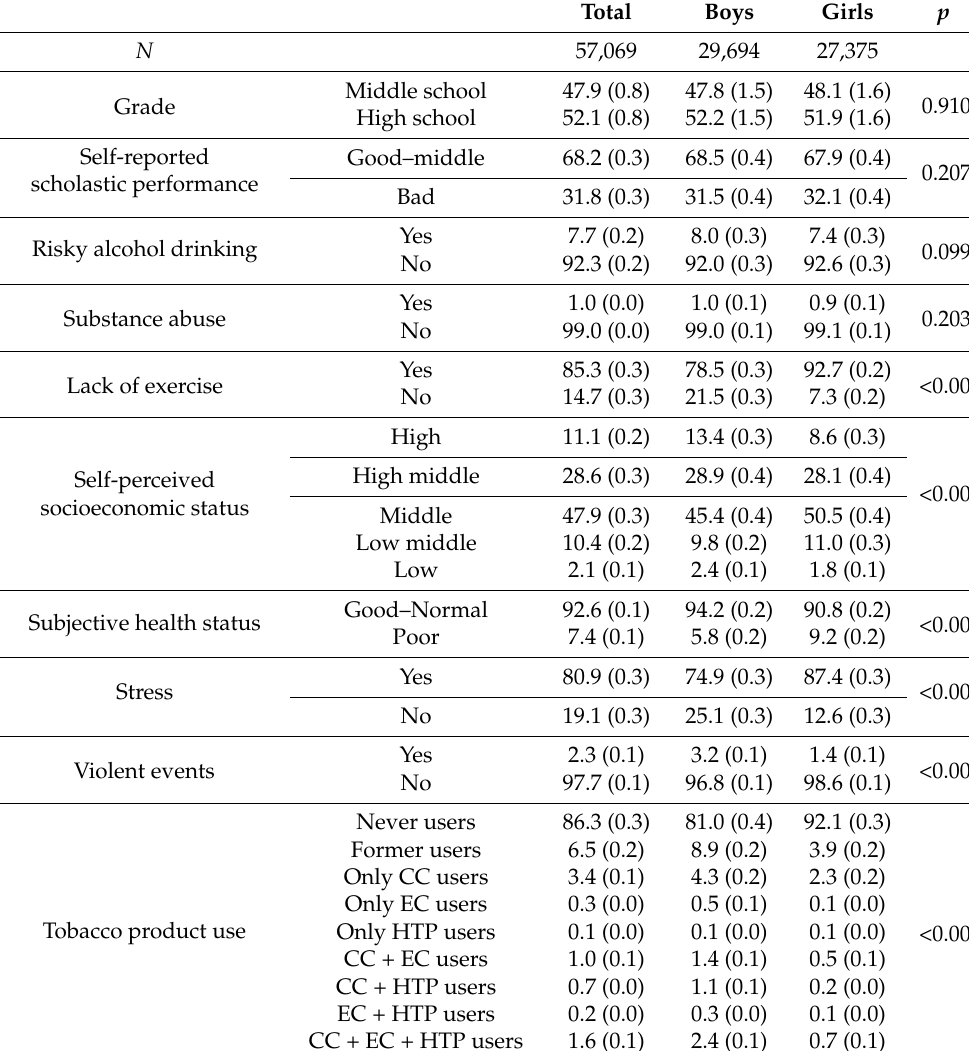
Table 1. Characteristics of study